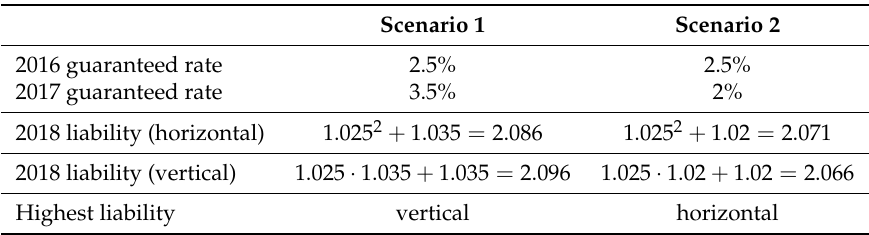
Table 1. Simple example illustrating how the horizontal and vertical methods are applied to the plan